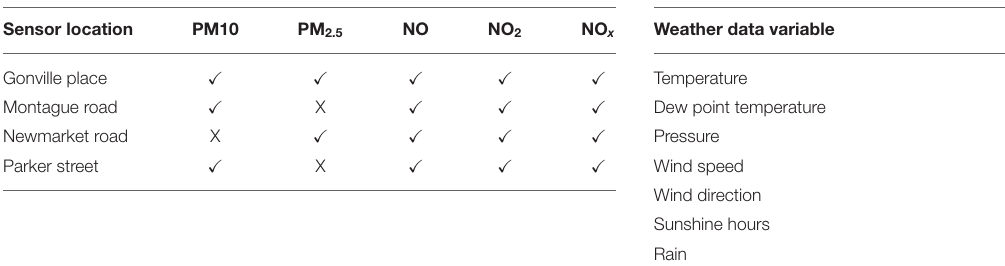
TABLE 2 | Weather data variables and their units in the data